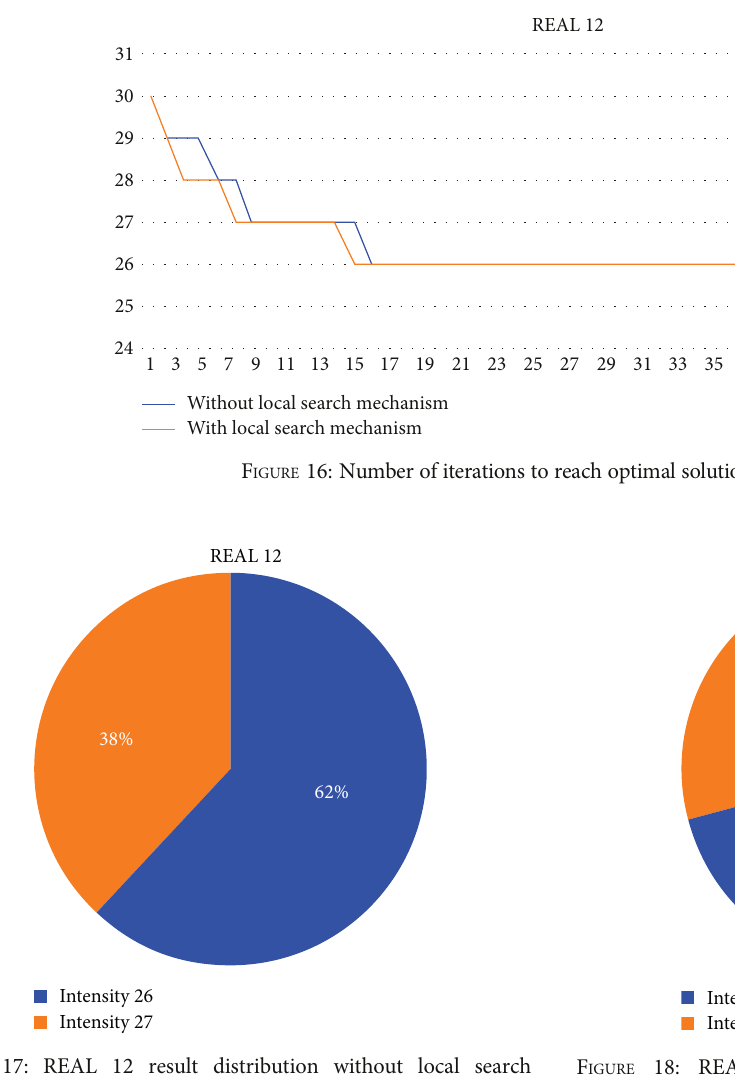
F IGURE 18: REAL 12 result distribution with local search mechanism.